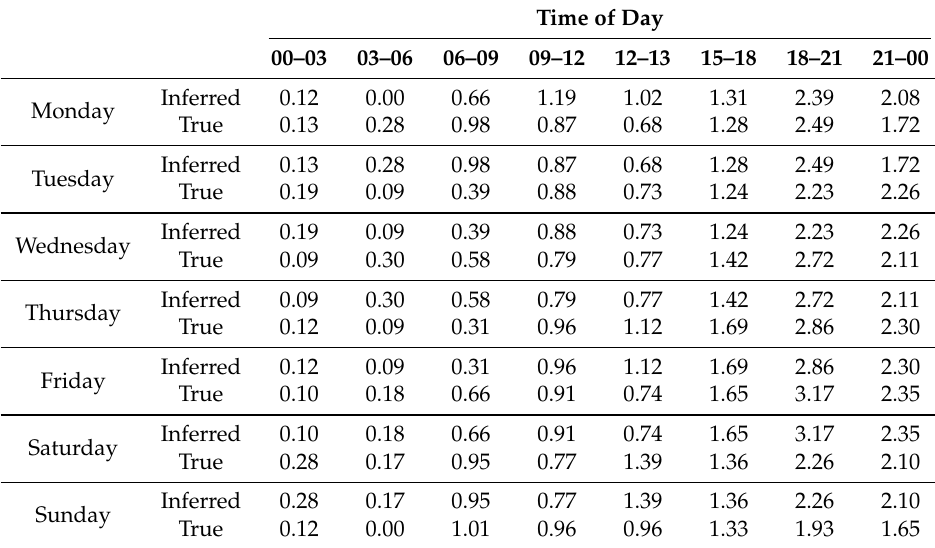
Table 1. Average viewership in a 6 weeks